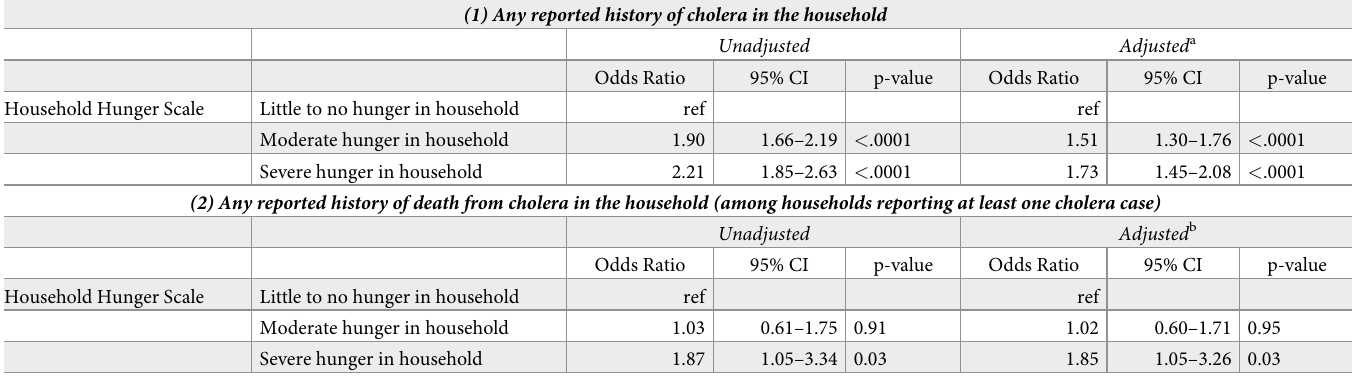
Table 3. Unadjusted and adjusted relationships between food security and (1) reported history of cholera by any member of the household since 2010 (Weighted N = 13,061), (2) reported history of death from cholera by any member of the household since 2010 among households reporting at least one cholera case (Weighted N = 2,104).